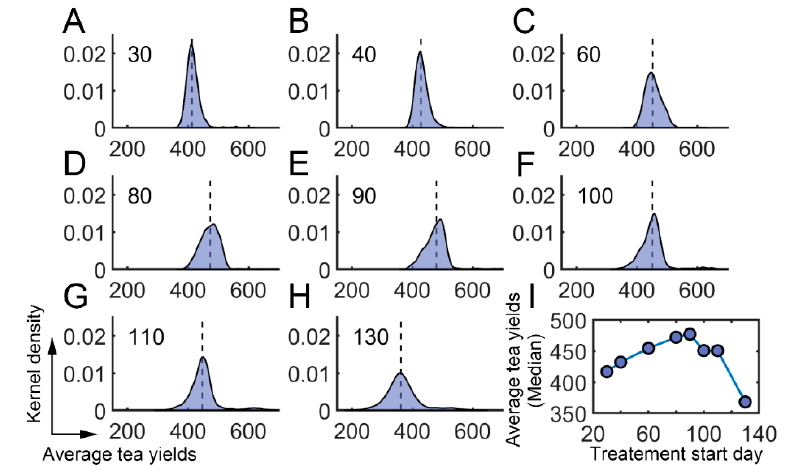
Figure 7. Effect of semiochemicals with different initial application times. ( A – H ) The average tea crop integral (tea yields) after applying semiochemicals as attractants on different days. ( A ) 30th day; ( B ) 40th day; ( C ) 60th day; ( D ) 80th day; ( E ) 90th day; ( F ) 100th day; ( G ) 110th day; ( H ) 130th day. ( I ) The median value of average tea crop integral with respect to treatment time.